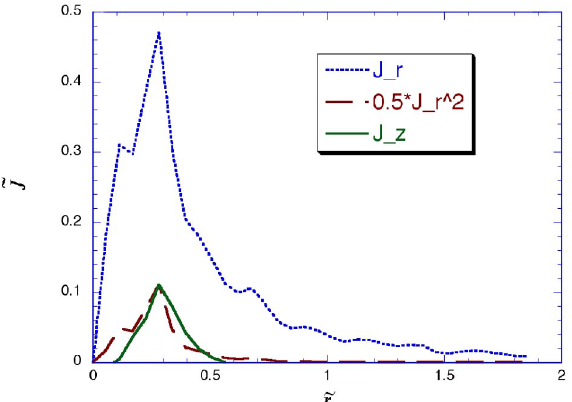
FIG. 5. (Color) Current densities just behind driving beam with ~ QQ (cid:4) 0 : 2 , uniform beam of width ~ aa (cid:4) 0 : 2 , length ~ ll Analytical prediction ~ JJ